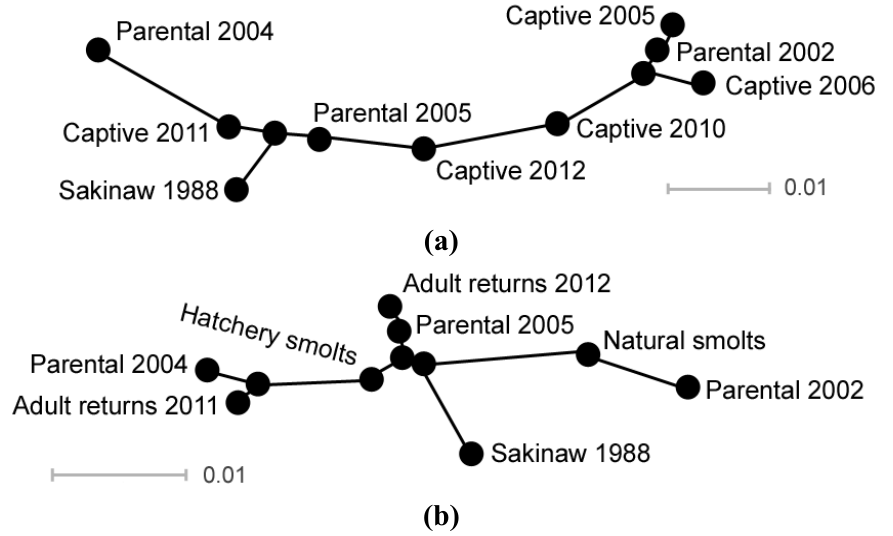
values among wild, captive ST